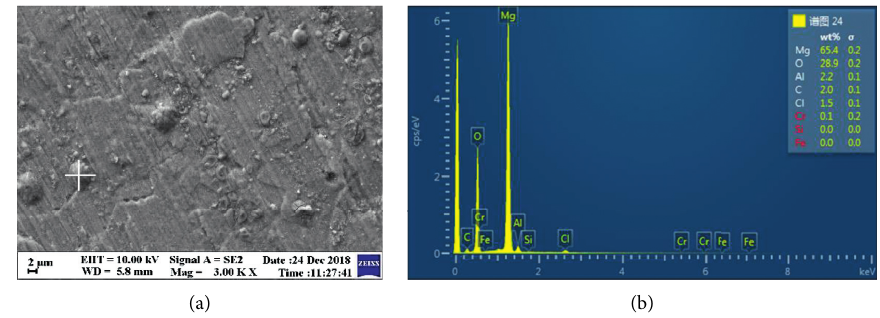
Figure 17: SEM (3000 times) micromorphology experiment and EDS analysis of the magnesium alloy plate heated by cathodic